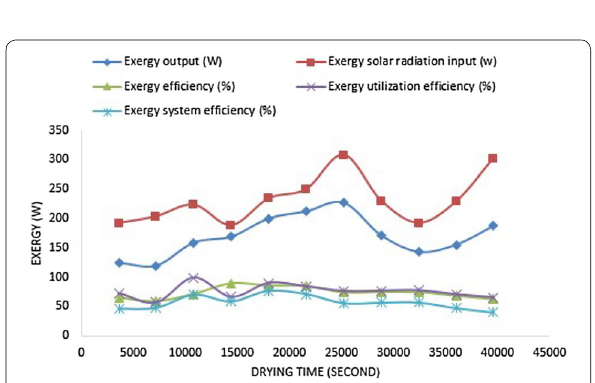
Fig. 22 Variation of efficiency as a function of drying time and exergy